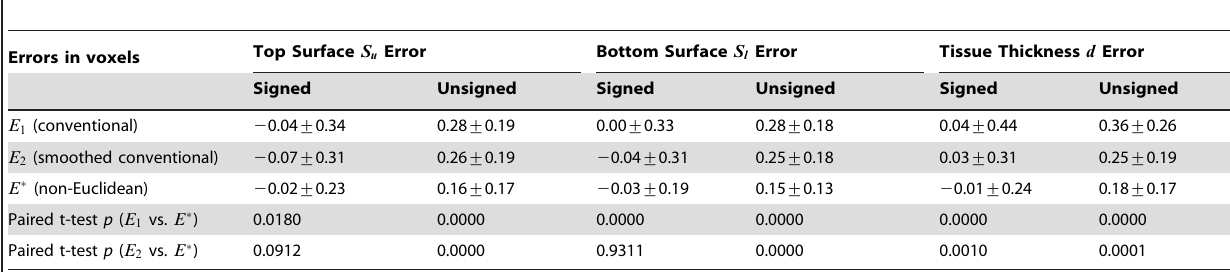
Table 1. Surface positioning error and thickness estimate error of region bounded by two coupled terrain-like surfaces ( E 1 : conventional graph search; E 2 : smoothed version of conventional graph search; E (cid:2) : non-Euclidean graph search).